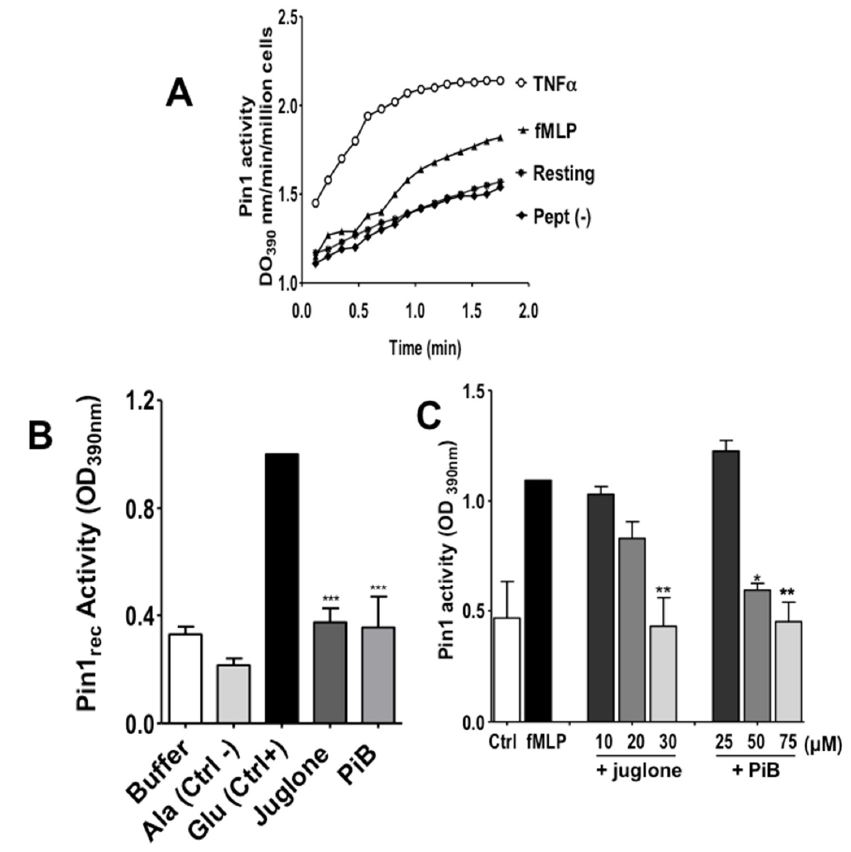
Figure 2. Effect of juglone and PiB on Pin1 activity and its activation in human neutrophils. ( A ) Neutrophils (1 × 10 7 /mL HBSS) were incubated in the absence (Resting) or presence of TNF α (20 ng/mL) for 20 min or fMLP (10 − 7 M) for 1 min. Neutrophils were lysed and Pin1 activity was measured using the Suc-AEPF-p-nitroaniline (pNA) peptide-Glu or Suc-AAPF-p-nitroaniline (pNA) peptide-Ala. The increase of pNA by chemotrypsin was detected at 390 nm. ( B ) Pin1 was expressed and purified from E. Coli and was incubated in the absence (Buffer) or presence of juglone or PiB and its activity was assessed using the Suc-AEPF-p-nitroaniline (pNA) peptide-Glu, a Pin1 substrate (Ctrl+) or Suc-AAPF-p-nitroaniline (pNA) peptide-Ala, a negative control peptide (Ctrl − ). The increase of OD due to pNA release by chemotrypsin was detected at 390 nm. ( C ) Neutrophils (1 × 10 7 /mL HBSS) were incubated in the absence or presence of different concentrations of juglone or PiB and stimulated by fMLP (10 − 7 M) for 1 min. Neutrophils were lysed and Pin1 activity was measured using the Suc-AEPF-p-nitroaniline (pNA) peptide-Glu. The increase of pNA by chemotrypsin was detected at 390 nm. Ctrl corresponds to resting neutrophils. Data are means ± S.E.M. of 3 separate experiments (* p < 0.05, ** p < 0.001, *** p < 0.0001 juglone and PiB as compared to